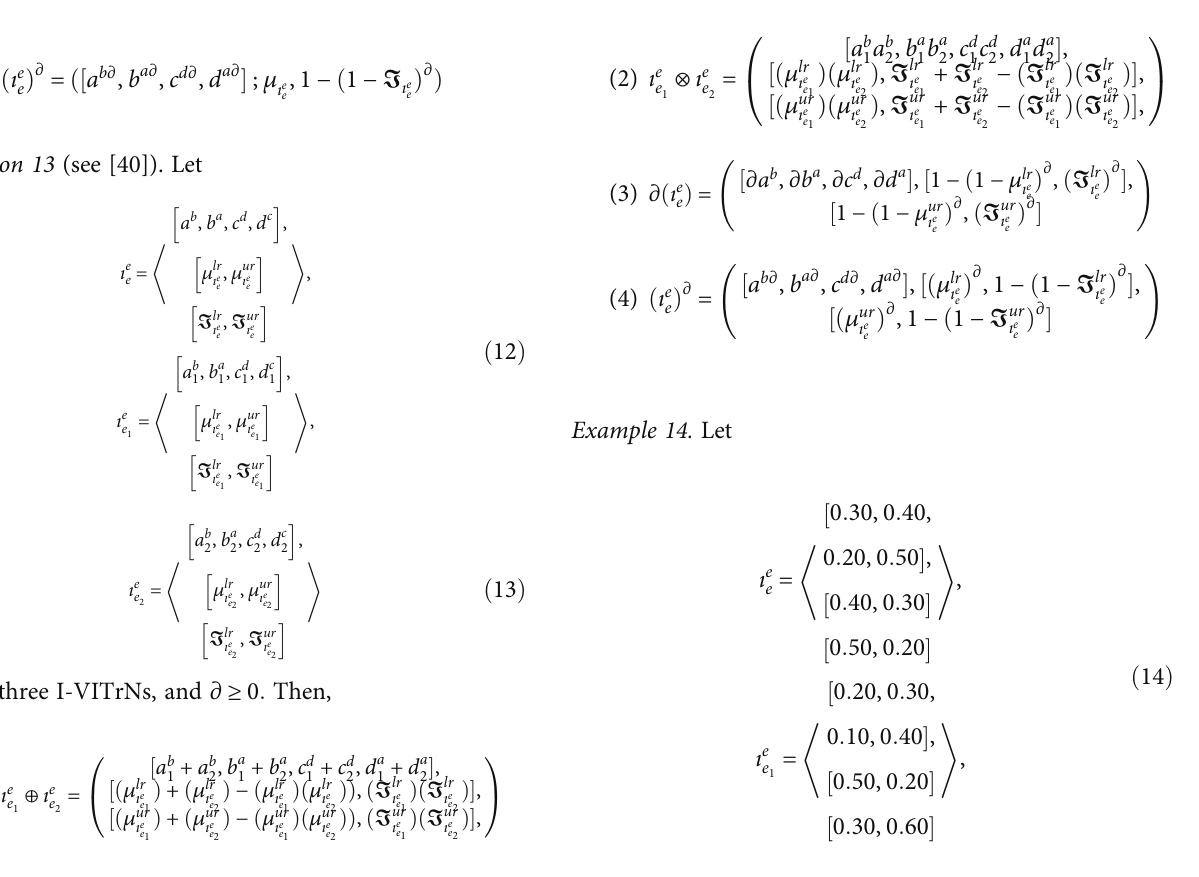
Figure 2: Graphical approach of accuracy